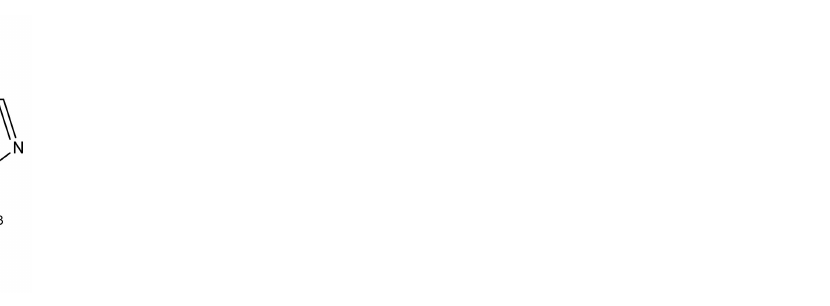
Figure 2. Possible hydrogen bonding in (1-methyl-4-nitropyrazol-5-yl)(1,2,4-triazole-4-yl)amine ( 20 ). In addition, the formation of a hydrogen bond in (1-methyl-4-nitropyrazol-5-yl) (1,2,4- triazol-4-yl) amine ( 20 ) is also evidenced from the rather large chemical shift of the NH proton (14.1